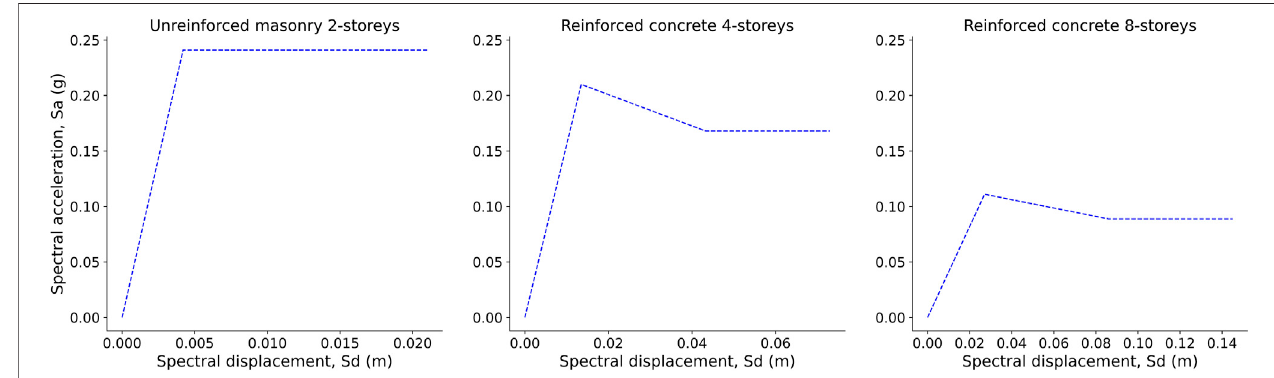
FIGURE2| Capacitycurves forthethreetypologiesconsidered.Left:unreinforcedmasonrytwo-storeys(MUR-H2).Center:reinforced concretefour-storeys(CR- H4). Right: reinforced concrete eight-storeys (CR-H8).